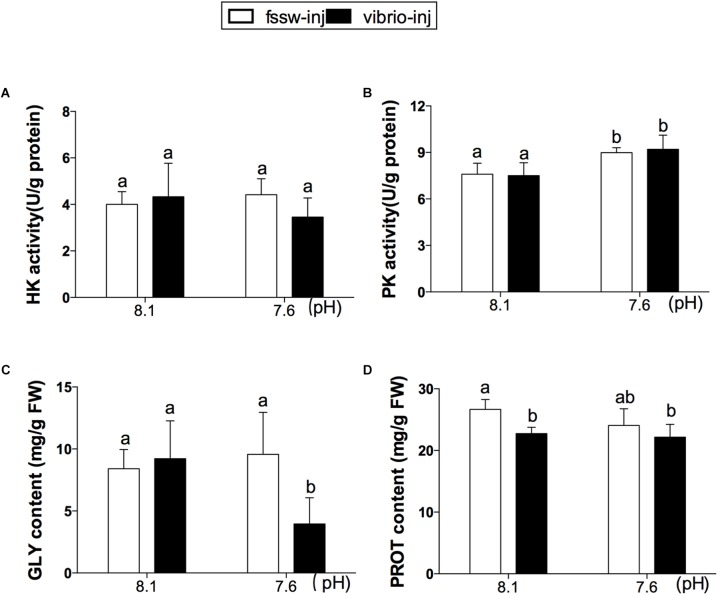
Glycolytic enzyme activities and energy reserves in the digestive glands of C. gigas post elevated pCO2 and/or V. splendidus exposure. (A) HK activity. (B) PK activity. (C) GLY content. (D) PROT content. Each bar represents mean ± SD (n = 6). Different letters indicate significant differences among different treatments (p < 0.05).